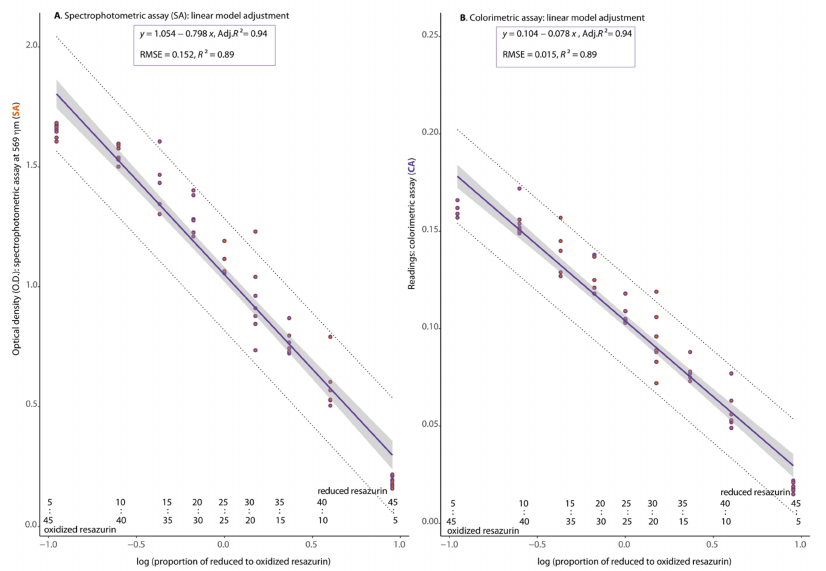
Figure 4. Simple linear regression models predicting the correspondence between the optical density (O.D.) estimates from the resazurin-based spectrophotometric assay at 569 nm (SA = SPEC-assay) or the readings from the resazurin-based colorimetric assay (CA = COL-assay) on the basis of the proportion of reduced to oxidized resazurin (RZ) for Mycosphaerella musicola